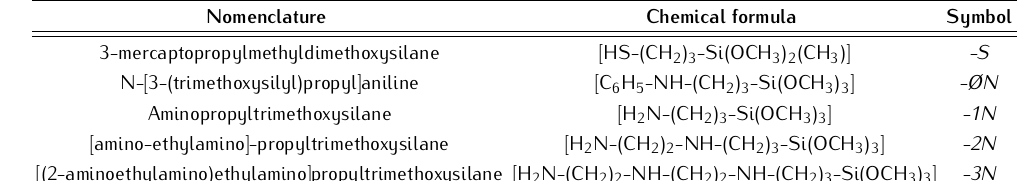
Table 1. Nomenclature and chemical formula of the organoalkoxysilanes used.